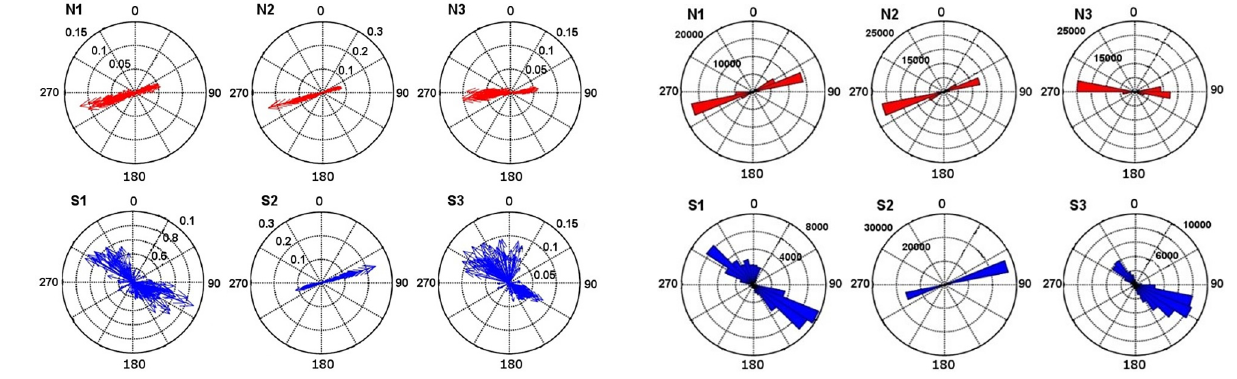
Figure 6. Simulated current velocities and directions at recording stations N1, N2, N3, S1, S2 and S3. The current vector polar plots (left) use radial increments in m/s. The current direction histogram (right) uses 11.25°